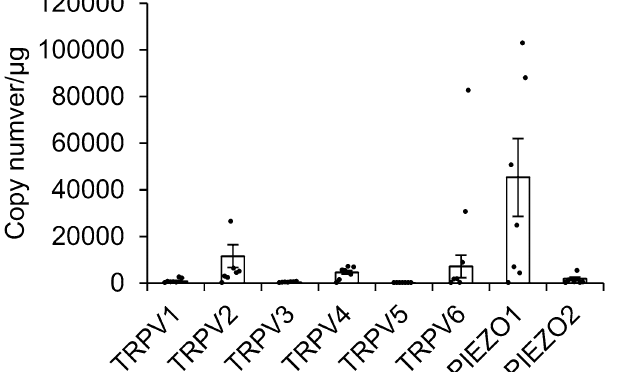
Figure 1. Expression levels of TRPV and Piezo family in human trabecular meshwork cells. mRNA levels of TRPV1-6 and Piezo1-2 in the human trabecular meshwork (hTM) cells were determined by qPCR. The number of mRNA copies of the target genes was calculated by normalizing to the amount of total RNA. Data are presented as means ± SD (n = Eight hTM cell populations from eight